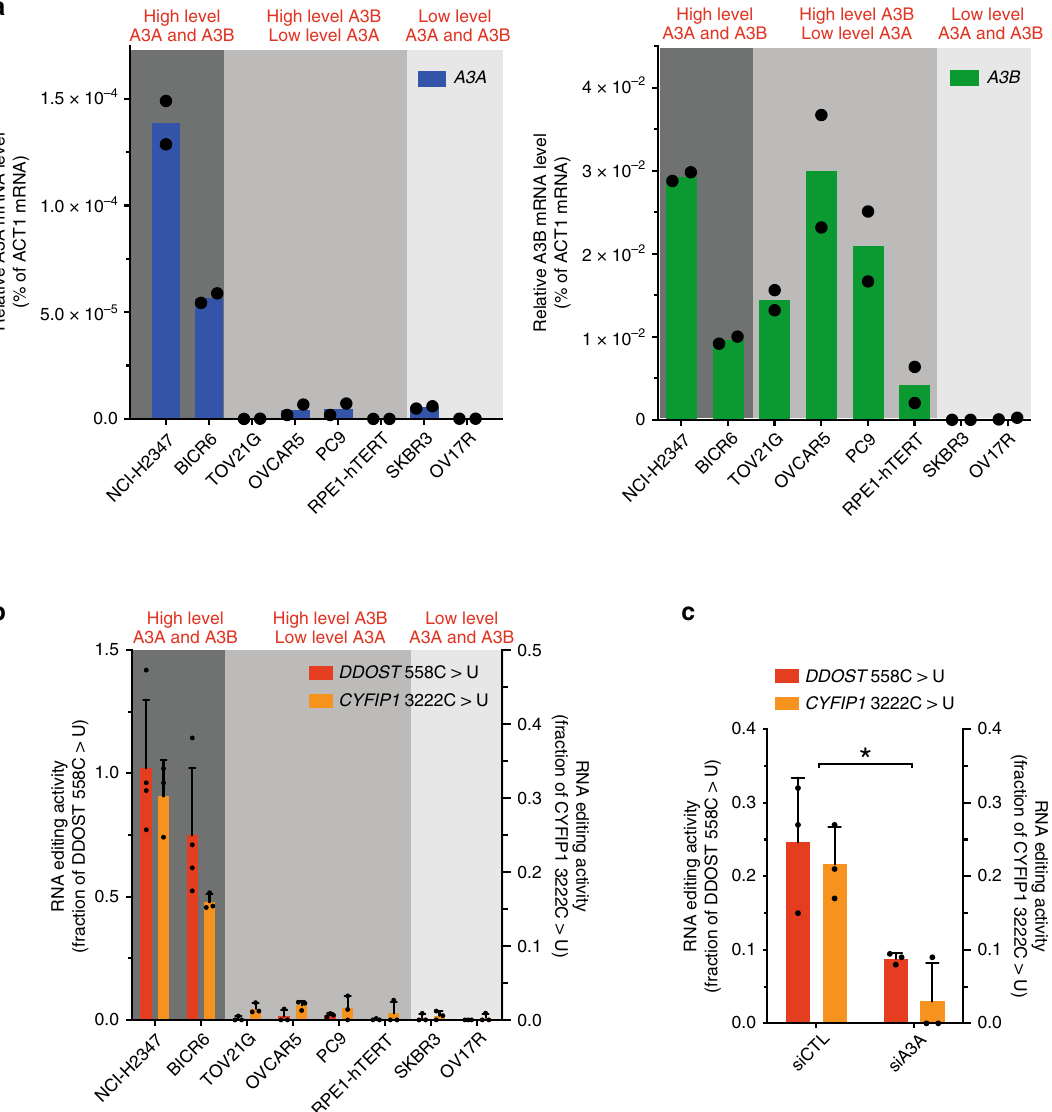
Fig. 5 Correlation between APOBEC3A expression and RNA editing activity in a panel of cancer cell lines. a Analysis of A3A and A3B mRNA expression in a panel of cancer cell lines determined by RT-qPCR. Error bar: S.D. ( n = 2). b Quanti fi cation of DDOST 558C>U and CYFIP1 3222C>U levels in BICR6 cells by ddPCR assay after A3A knowndown. Error bar: S.D. ( n ≥ 3). c Quanti fi cation of edited DDOST 558C>T and CYFIP1 3222C>T by ddPCR assay. Error bar: S.D. ( n = 3). (* p = 0.0352 for DDOST and p = 0.0111 for CYFIP1 by two-tailed t -test) Source data are provided as a Source Data fi